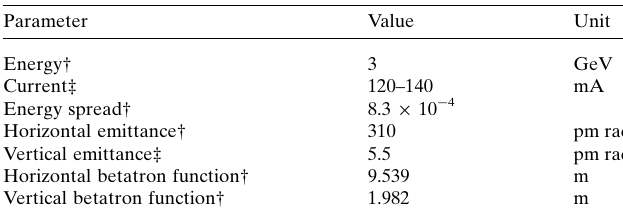
Table 1 Parameters of the storage ring used in the calculations.